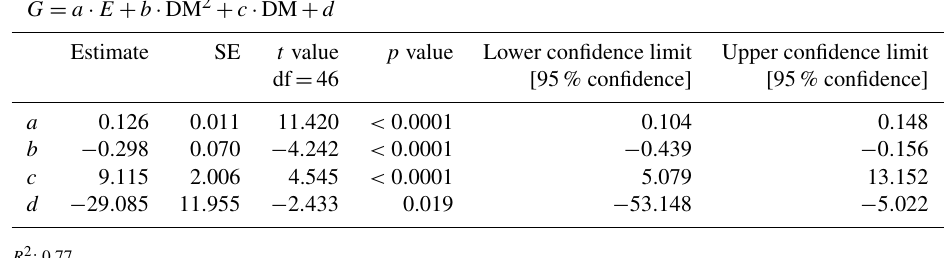
Table 2. Description of the statistical model parameters (Fig. 5) combining the influence of irradiance ( E , µmolm − 2 s − 1 ) and clam dry mass (DM; g) on calcification ( G ; µmolCaCO 3 ind − 1 h − 1 ), where d is the fitted intercept.